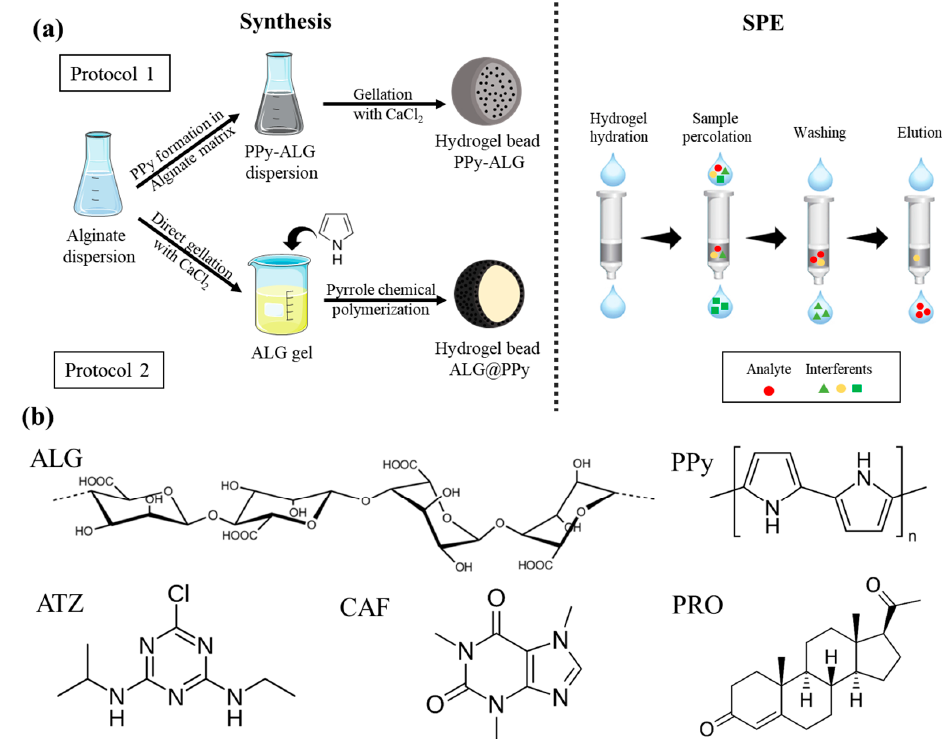
Figure 1. ( a ) Protocols for the formation of hydrogels modified with polypyrrole. In the first protocol, an alginate hydrogel containing polypyrrole particles is formed, while in the second protocol, alginate hydrogels are covered with a polypyrrole layer. All hydrogels were later applied as extraction phases in SPE (Solid Phase Extraction). ( b ) Structure of all chemicals used. ALG and PPy were used to form the hydrogels, and ATZ, CAF, and PRO were the CECs used to evaluate the extraction behavior of the composite.